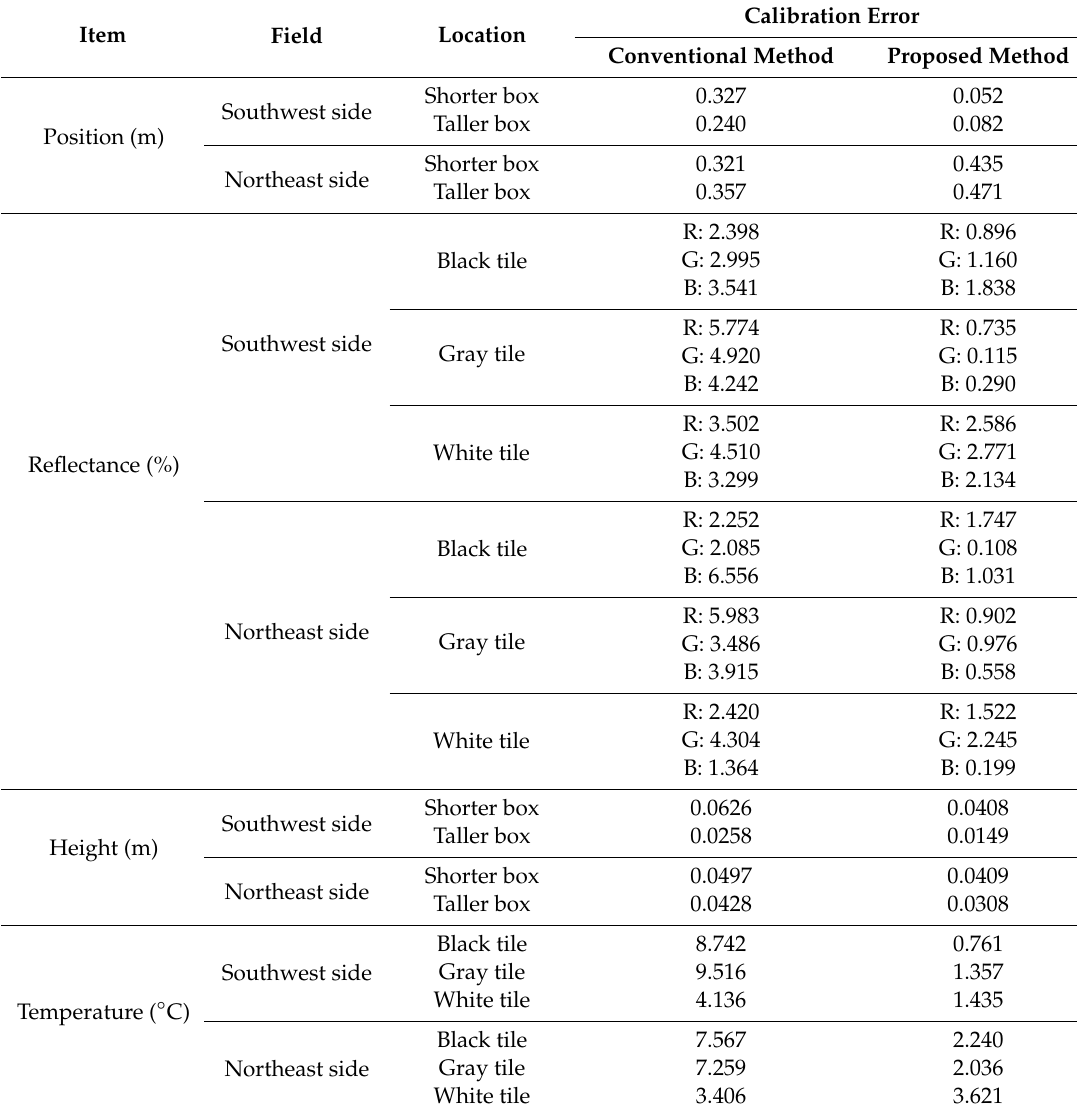
Table 2. Accuracy improvements results between conventional method and proposed method from the georeferencing, radiometric calibration, height calibration, and temperature